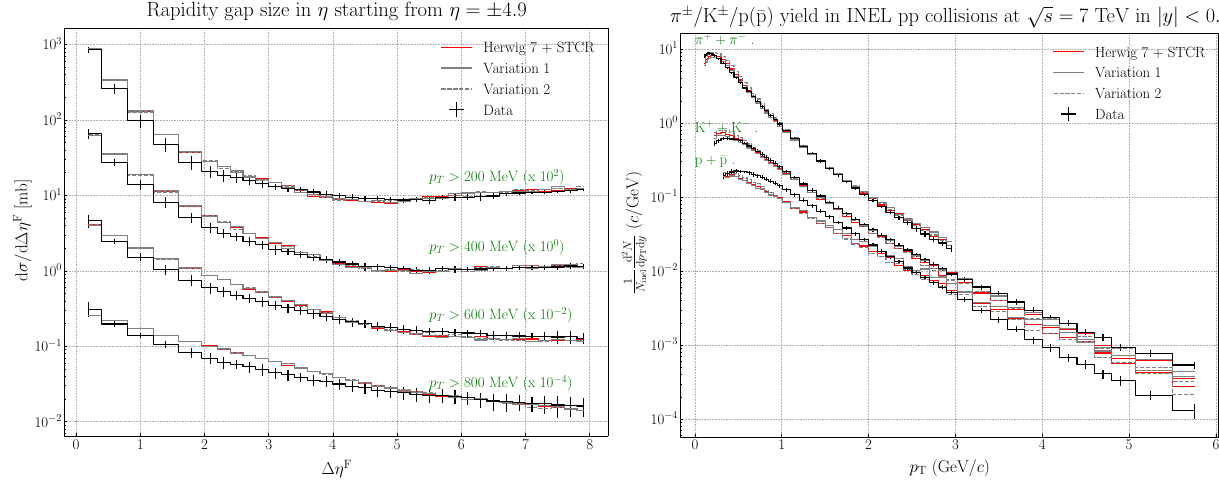
Fig. 11 Predictions for the rapidity gap fraction and the pion, kaon, and proton yields as measured by [53,59]. Variations in the spacetime components of the model show very little impact on the results